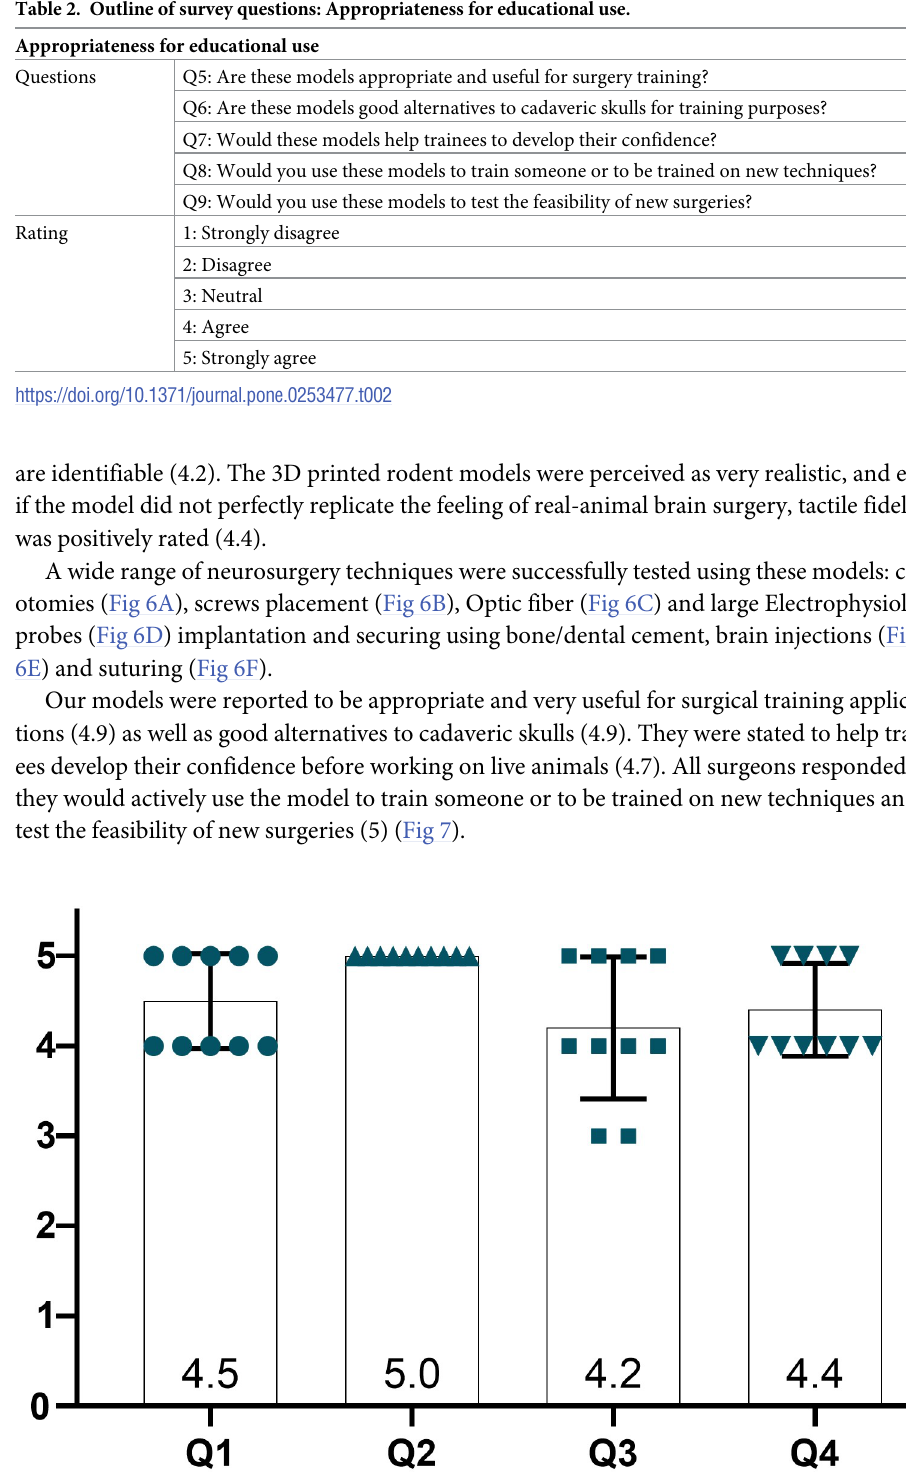
PLOS ONE | https://doi.org/10.1371/journal.pone.0253477 June 23,